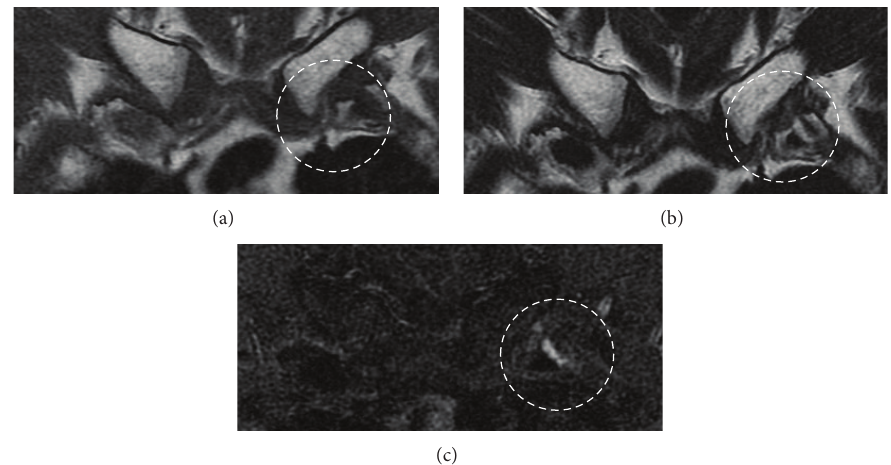
Figure 2: Magnetic resonance imaging of the bilateral first sternocostal synchondrosis. Coronal T1-weighted image (a), T2-weighted image (b), and STIR image (c) are shown. STIR image showing a high-intensity lesion at the left first sternocostal synchondrosis.